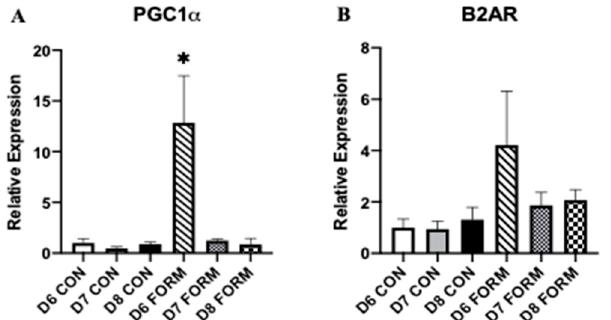
Figure 3. For each figure (n = 5), the symbol (*) is used to represent a significant difference between conditions. PGC-1 α ( A ): D6 FORM was increased compared to all other conditions ( p < 0.05). B2AR ( B ): There were no changes in expression between conditions.